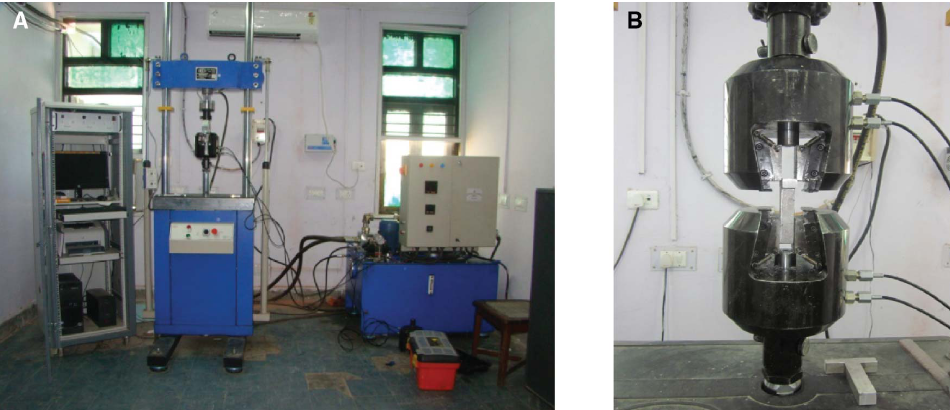
Figure 5: (A) Fatigue testing machine. (B) Clamping fixture of the